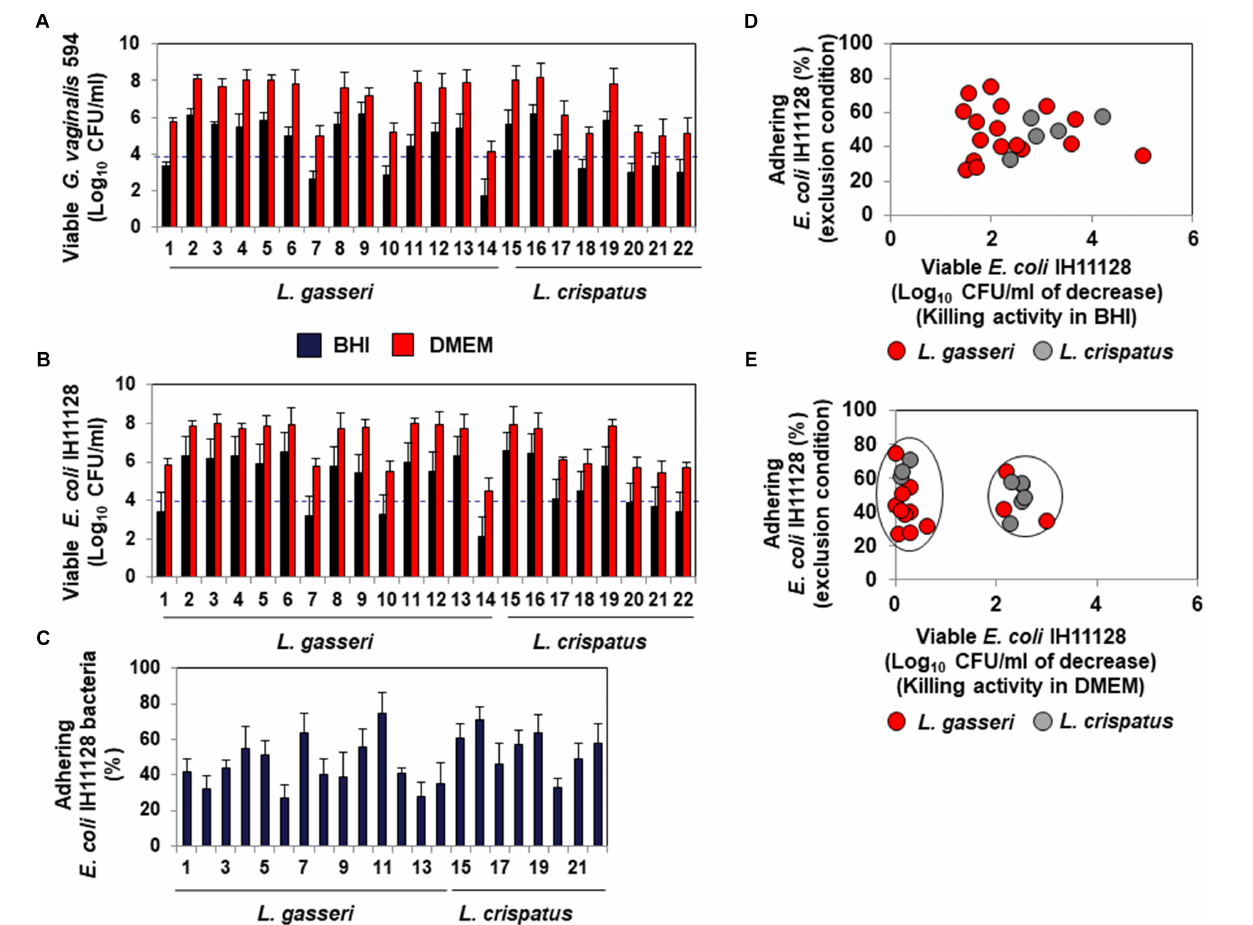
FIGURE 6 | Distribution of the killing activities and adhesion inhibition activity among L. gasseri and L. crispatus strains isolated from cervicovaginal samples of healthy women. (A) Killing activity against BV-associated G. vaginalis 594 was determined in the presence of BHI or DMEM. (B) Killing activity against recurrent cystitis- and preterm labor- associated UPEC IH11128 was determined in the presence of BHI or DMEM. (C) Competitive inhibition activity exerted by L. gasseri and L. crispatus strains against adhesion of UPEC IH11128 onto cervicovaginal epithelial HeLa cells. (D) Strain-by-strain expression of total killing activity (in the presence of BHI) versus inhibition of pathogen adhesion by Lactobacillus cells. (E) Strain-by-strain expression of killing activity independent of secreted lactic acid (in the presence of DMEM) versus inhibition of pathogen adhesion by Lactobacillus cells. In (A,B) , the killing activity was measured after 4 h of direct contact with the pathogens (Control: 5 × 10 8 CFU/ml). The dotted line shows the MBE 99 . 99% value, defined as a reduction in the viable cell count of 4 log 10 CFU/ml. In C, the inhibition of adhesion was measured after 3 h of incubation. 100% UPEC IH11128 adhesion corresponds to 7.1 ± 0.7 CFU/ml. Each value shown is the mean ± SD from three experiments. Graphs in (D,E) were constructed by plotting the killing activities (measured in the presence of BHI or DMEM) shown in Figure 1B versus the exclusion inhibition activities shown in Figure 1C